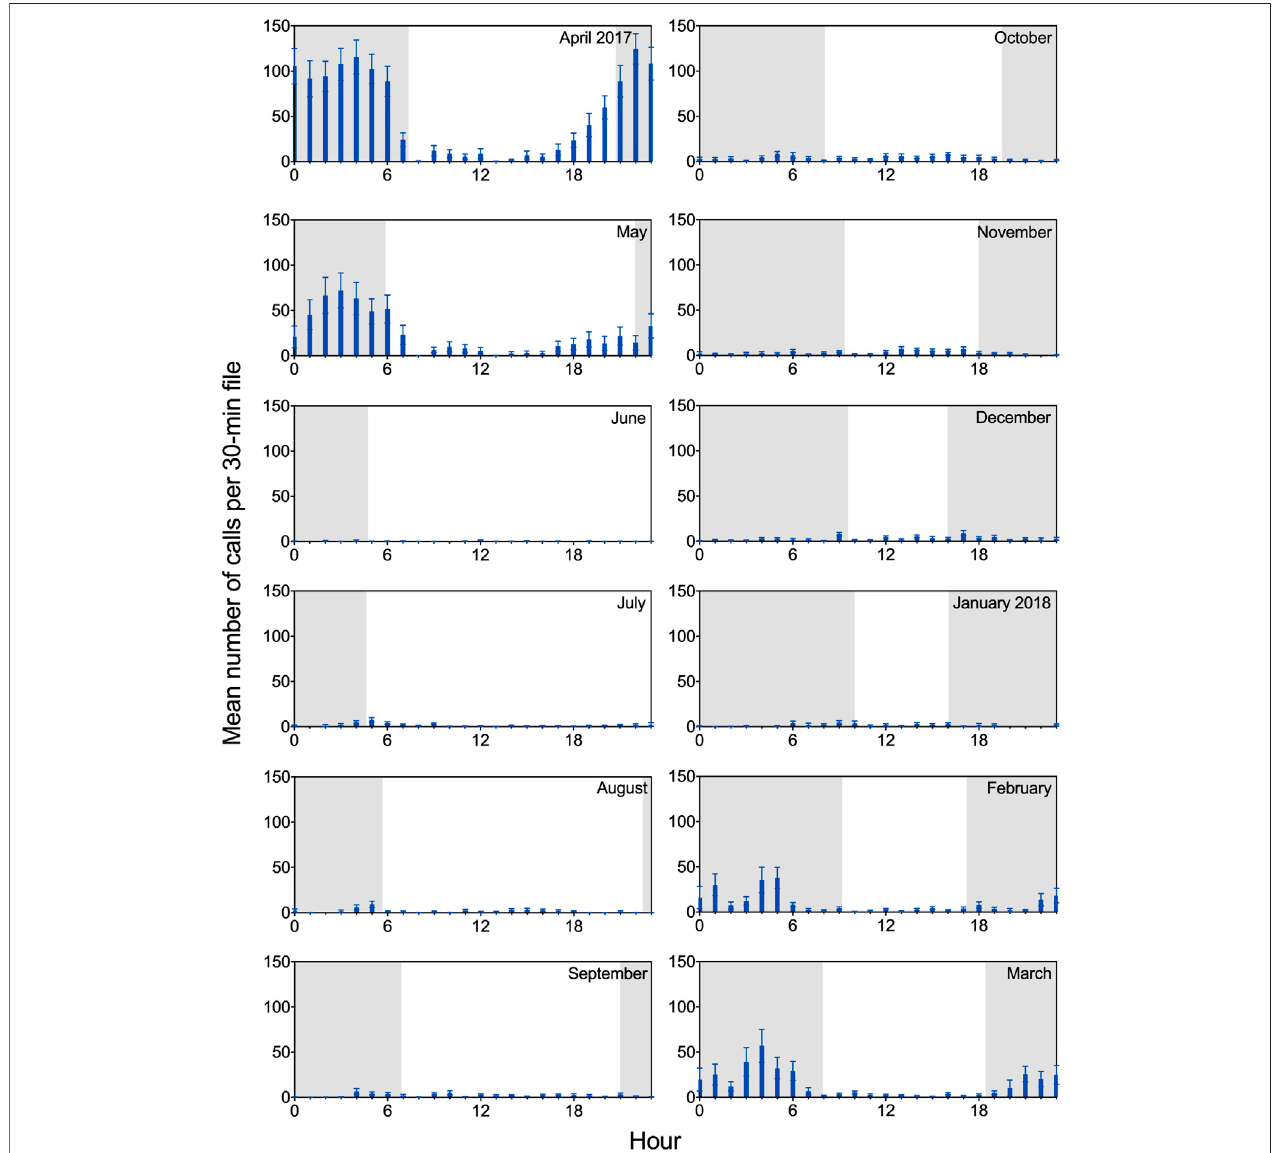
FIGURE 4 | Diel patterns in calling for two adult male spotted seals. Mean (and SEM) number of calls per 30-min fi le is shown for a 12-month period (April 2017 throughMarch2018),binnedinhourlyintervals.Eachmonthincludes427 – 74430-min fi les.Shadingrepresentsphotoperiod,withnighttimeintervalsshaded.Observed peaks in diel calling behavior occurred during darkness when husbandry staff were offsite. For example, for the month of April — when maximum calling rate was observed — Amak and Tunu typically received their daily training sessions between 0800 and 1700, while maximum vocal activity occurred between 2100 and 0600. Molt occurred between 15 May and 20